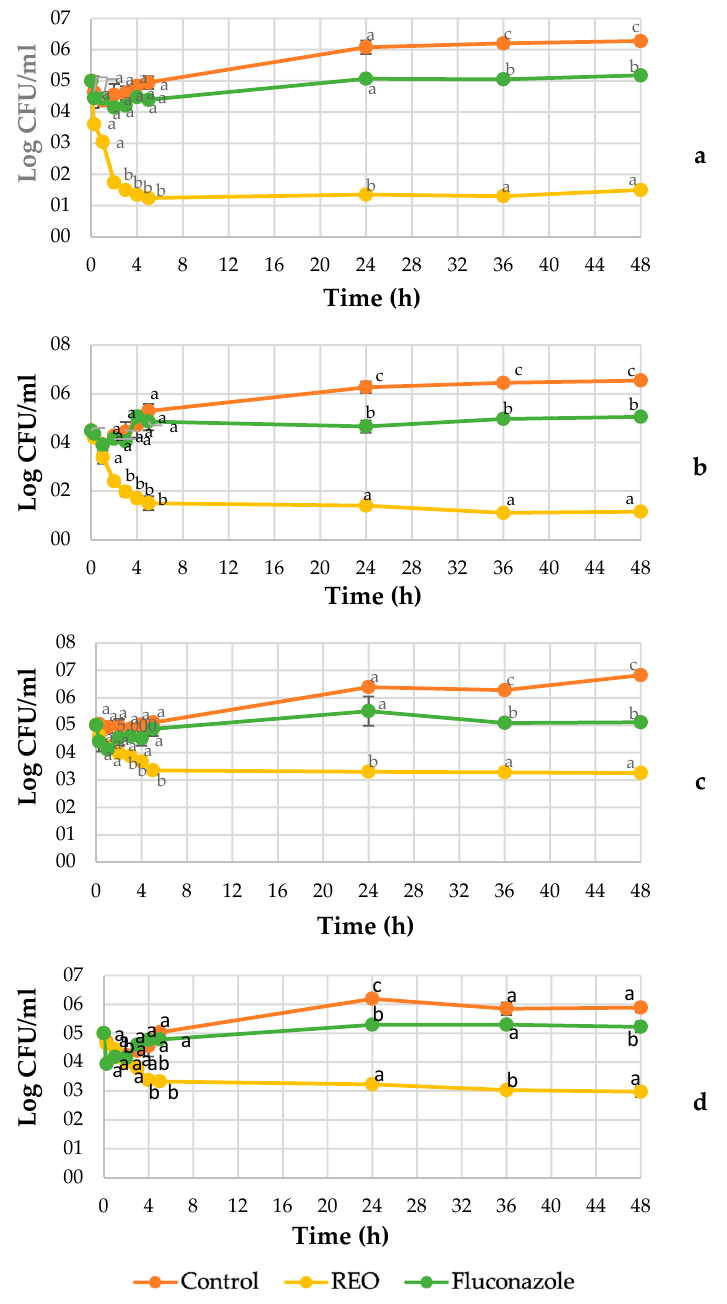
Figure 1. Time–kill kinetics for 8.2 µg/mL of REO and fluconazole against Candida tropicalis ORL21 ( a ), Candida tropicalis ORL20 ( b ), Candida albicans ORL08 ( c ), and Candida albicans ORL03 ( d ) at 37 °C. Results are according to ANOVA test mean values and intervals based on Tukey test for treatments with 95%. Different lowercase letters (a, b, c) indicate significant differences between treatments according to the Tukey test in a confidence interval of 95%.